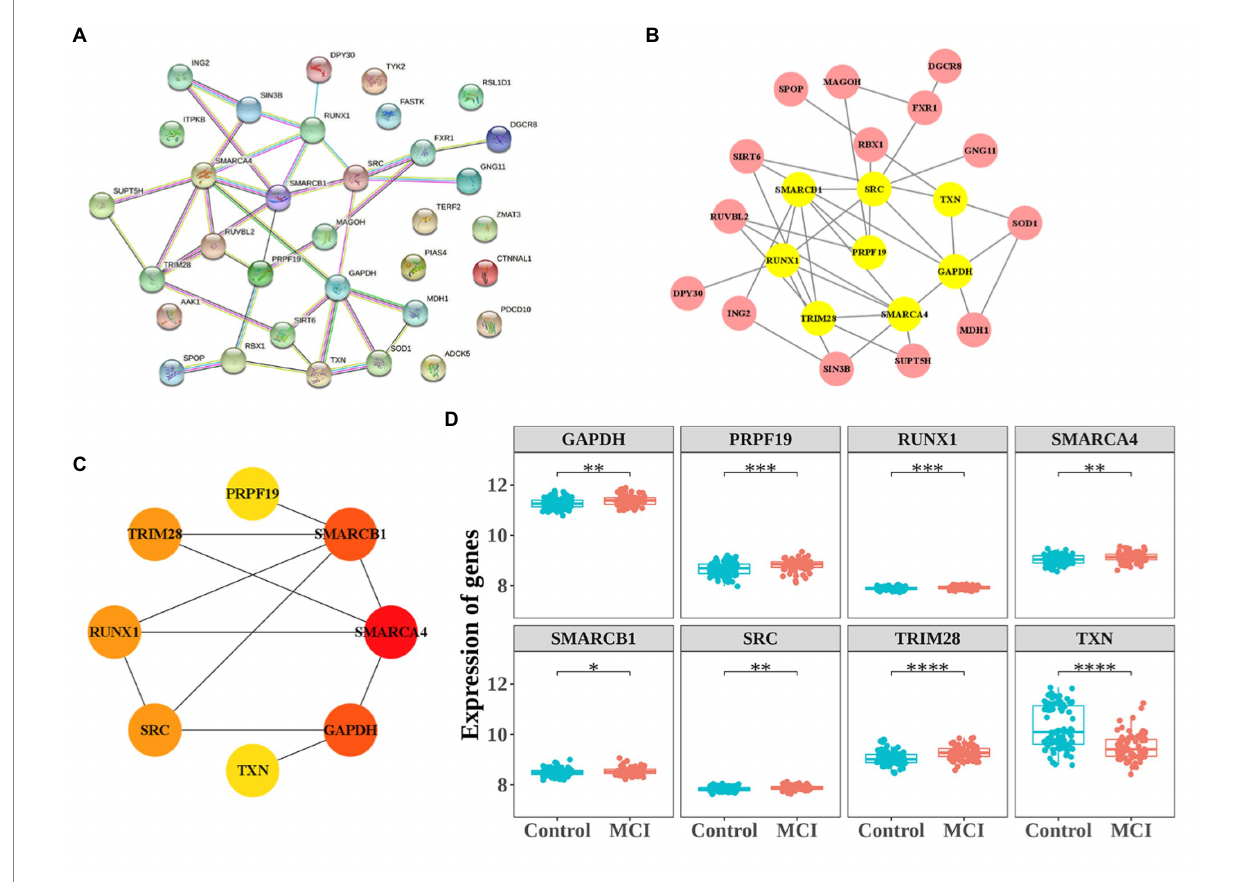
FIGURE 5 Protein–protein interaction (PPI) network construction and the expression of 8 hub-genes. (A) PPI network constructed with the CS-DEGs. (B,C) The significant module identified from the PPI network using the molecular complex detection (MCODE) method. (D) The expressions of 8 hub-genes.